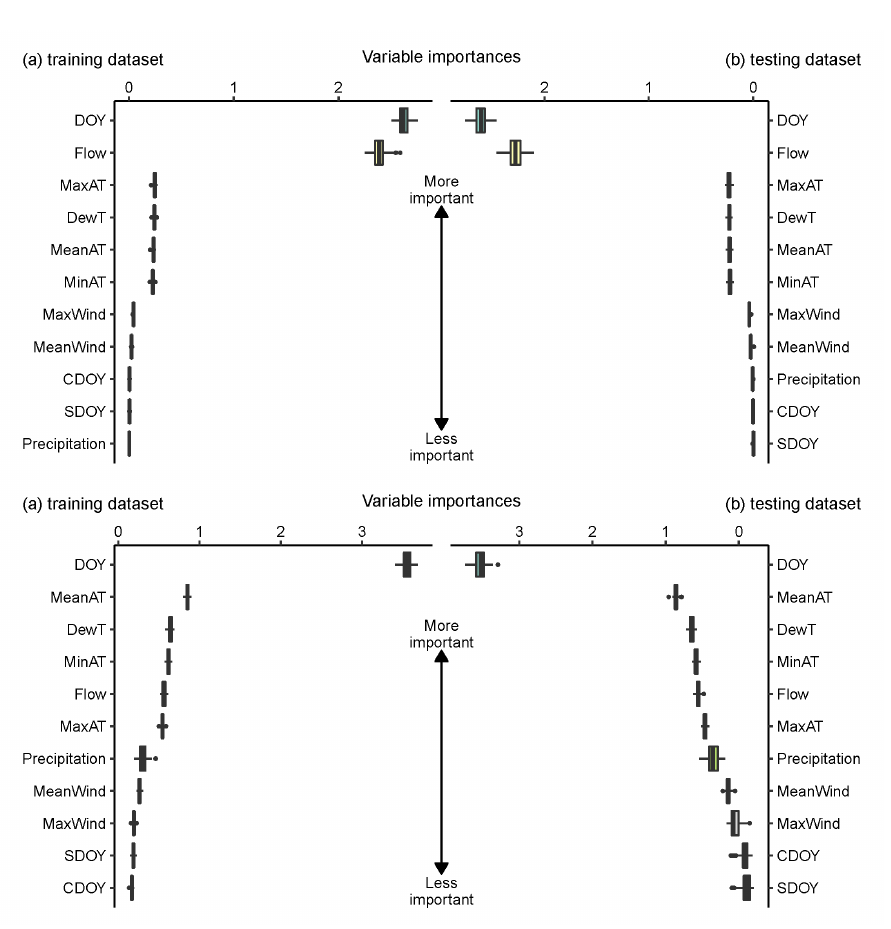
Figure 6. Permutation importance in SVR and MLPNN; SVR, support vector regression, MLPNN, multilayer perceptron neural networks. (SVR on the top , MLPNN on the bottom , WT: ◦